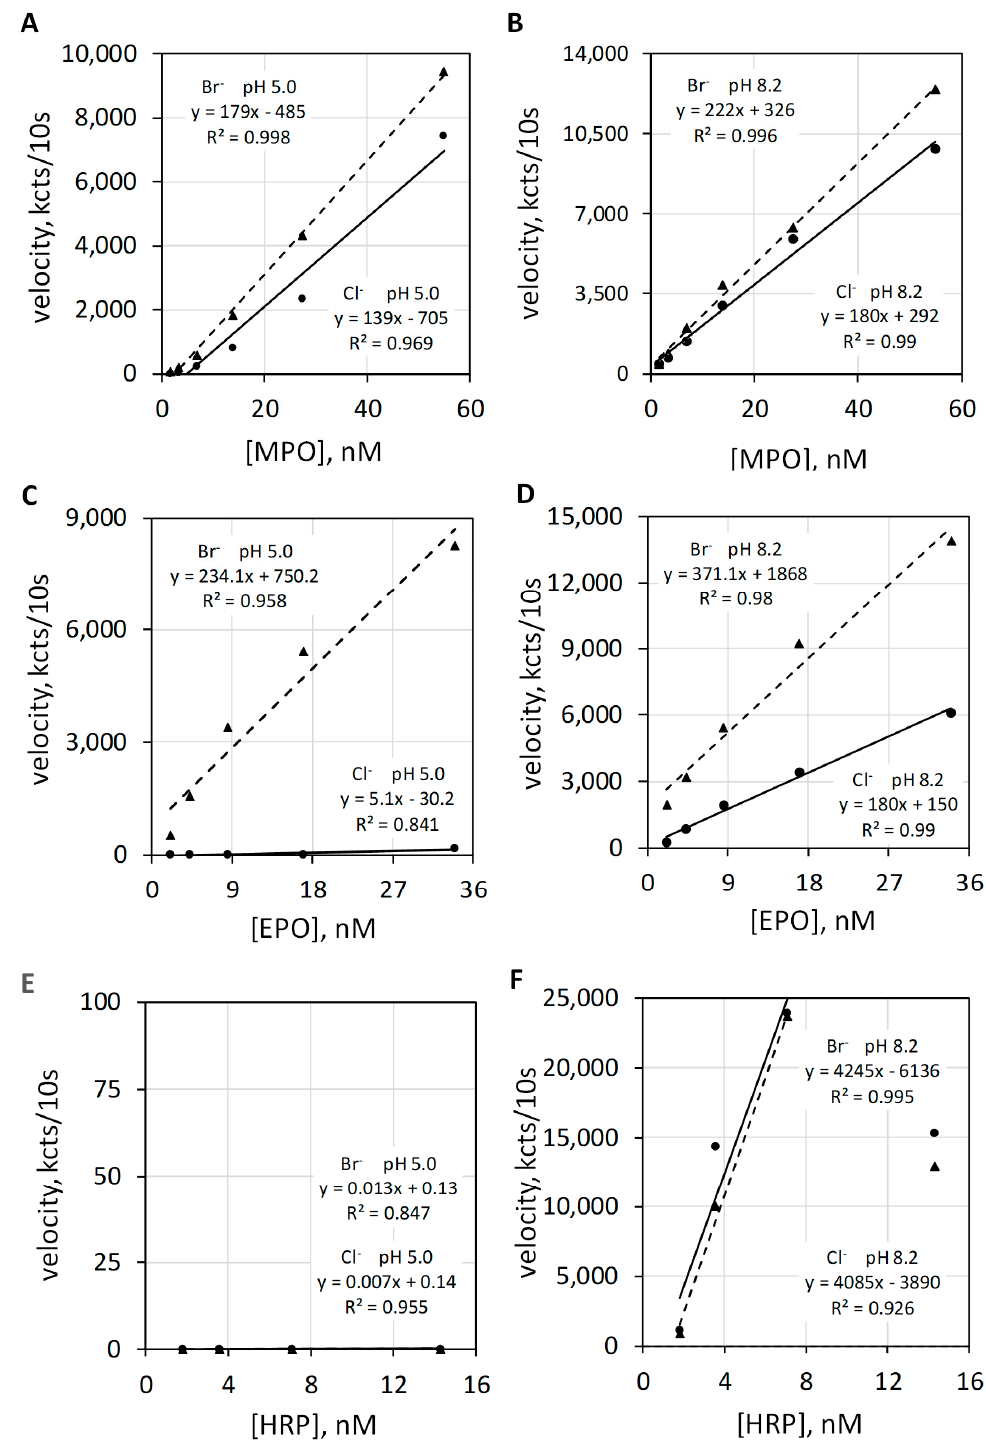
Figure 6. Luminol luminescence velocity plotted against MPO, EPO, and HRP concentration under acid and alkaline conditions. Varying concentrations of MPO ( A , B ), EPO, ( C , D ) and HRP ( E , F ) activities were measured in 50 mM acetate buffer at pH 5.0 ( A , C , E ) and in 50 mM phos- phate buffer at pH 8.2 ( B , D , F ). MPO, EPO, and HRP were measured with 100 mEq/L Cl − and with 2.5 mEq/L Br − . The luminol concentration was 50 µ M. Reaction was initiated by mixing reactants with 2.5 mM H 2 O 2 . The final volume was 1.0 mL. Velocity was measured as kilocounts collected during the initial 10 s post mixing and expressed as kcts/10